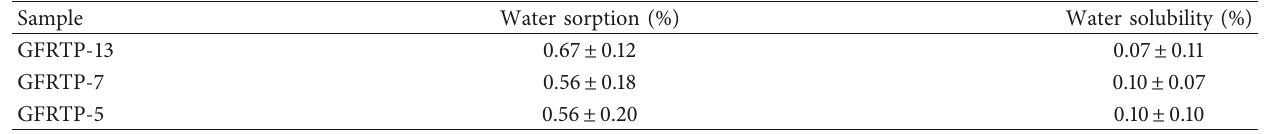
Mean values with the same superscripts are significantly different from each other ( p < 0 . 05). Table 5: Water sorption values and solubilities after immersion for 4 weeks.